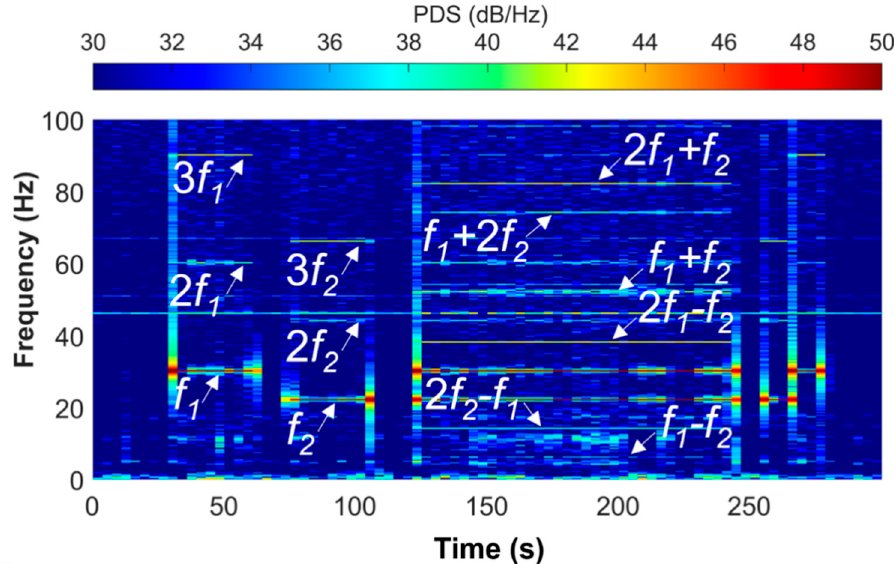
Figure 10. Spectrogram (power spectral density) of the signal recorded in the middle of the Bentheimer sandstone sample during the laboratory test. Fundamental frequencies f1 and f2, their harmonics and combinational products are annotated.